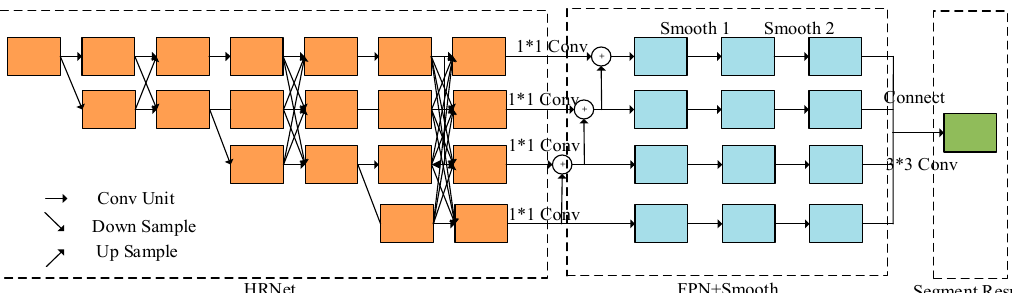
Figure 2. End-to-end automatic lunar feature extraction network based on the HR-GLNet.